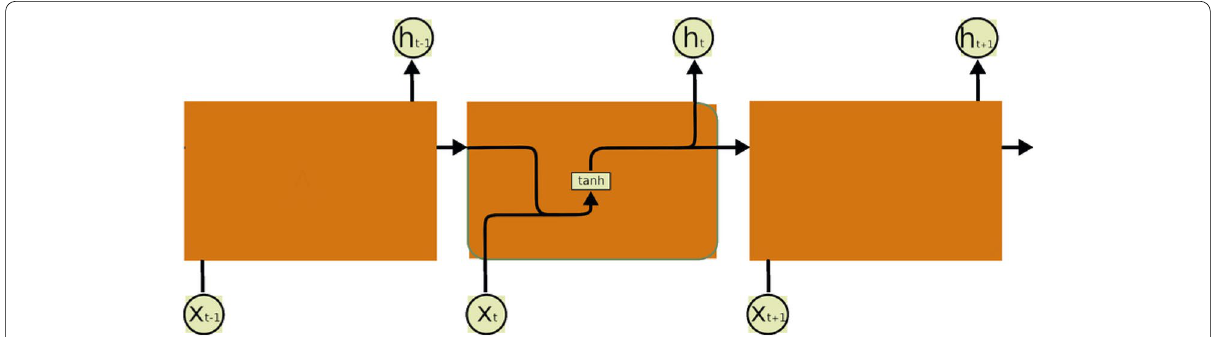
Fig. 3 Single recurrent neural network with a single repeating module. Source: Aibin, Michal. [1]